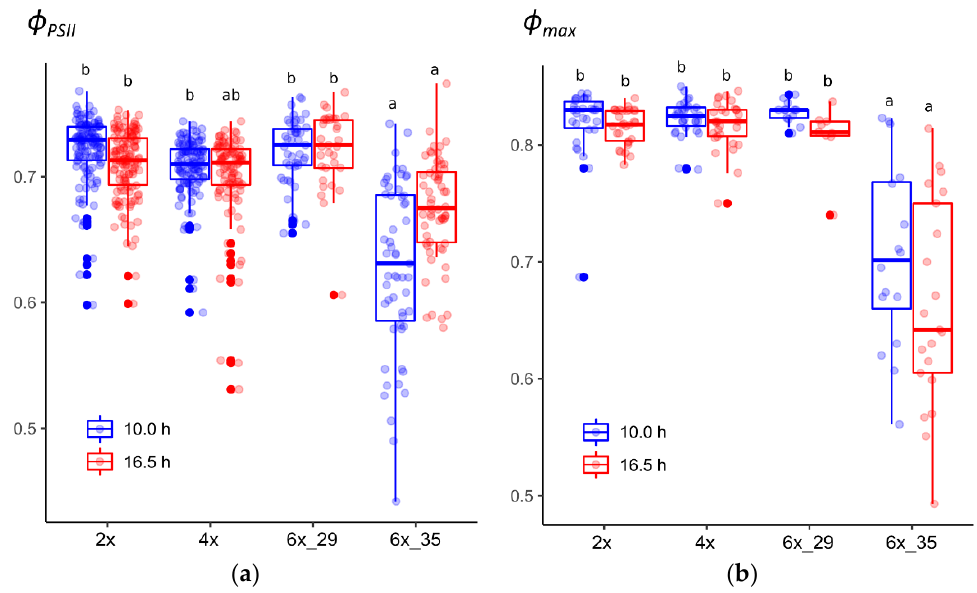
Figure 1. Quantum yields of R. auricomus cytotypes exposed to two different photoperiods: ( a ) po- tential quantum yield, ϕ PSII , from light-adapted plants; ( b ) maximum quantum yield, ϕ max , from dark-adapted plants. For summary statistics, see Table S3, letters represent 95% Tukey. Boxplots show the 25th, median, and 75th percentile range, and jitter plots represent the exact data distribu- tion .